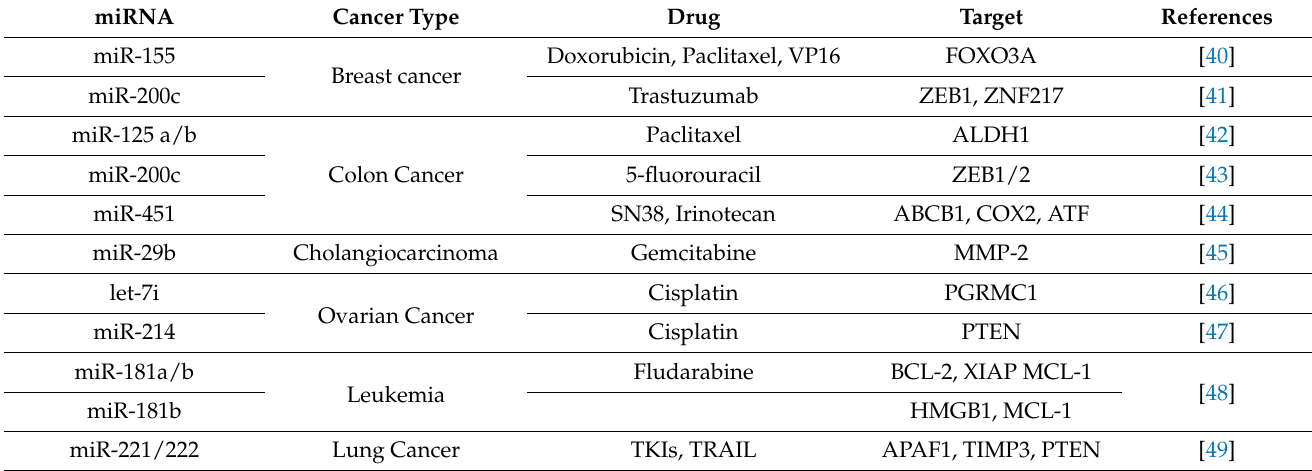
Table 2. Role of different miRNAs in developing chemotherapy resistance in different